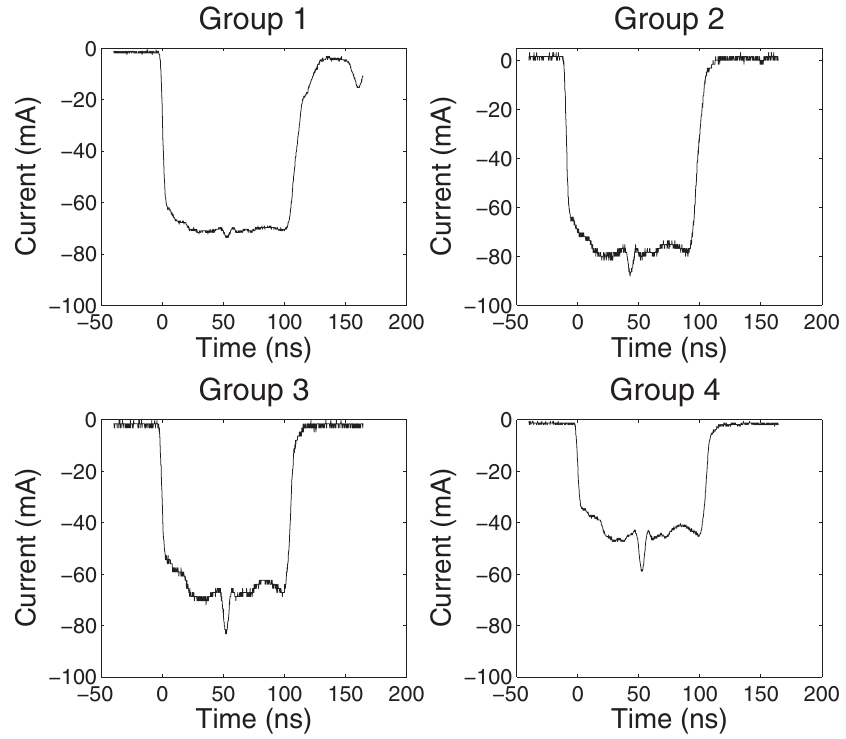
FIG. 2. Four groups of initial currents with perturbation.